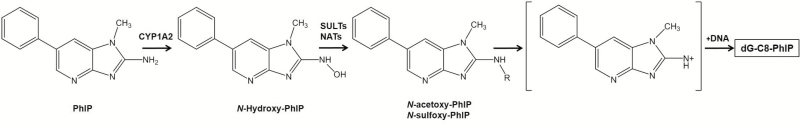
P450-mediated bioactivation pathway of PhIP.